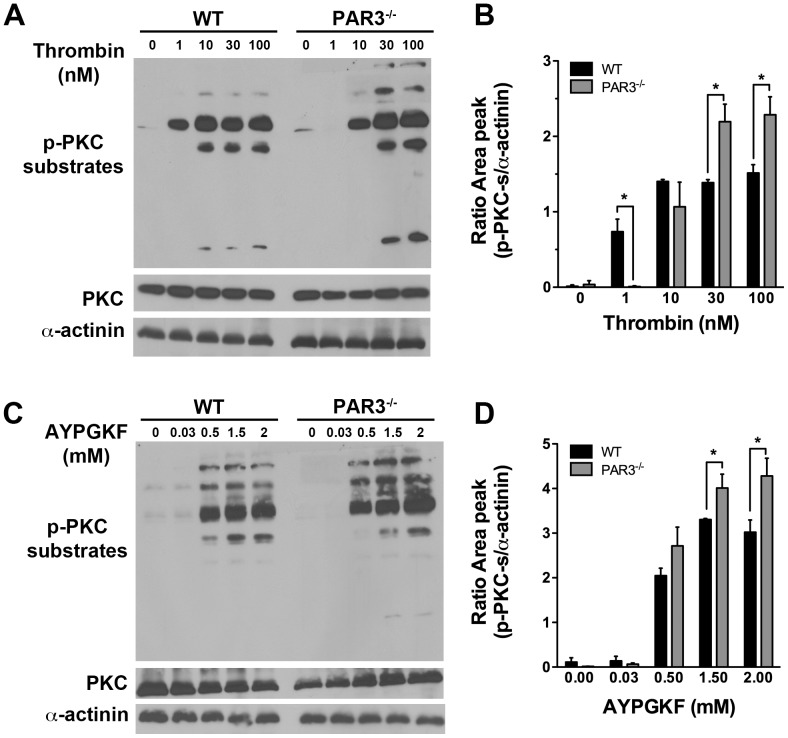
Western blot analysis of protein kinase C (PKC) substrate phosphorylation in mouse platelets.The level of PKC substrate phosphorylation on serine residues in response to increasing concentrations of: (A) thrombin (1–100 nM) or (C) AYPGKF (0.03–2 mM) was determined by western blotting with phospho-(Ser) PKC substrate antibody. The membranes were re-probed for α-actinin to demonstrate protein loading. The blots shown are from a representative of three independent experiments. Quantitation of PKC substrate phosphorylation in response to (B) thrombin or (D) AYPGKF is represented at the mean (± SD) (* p<0.05).